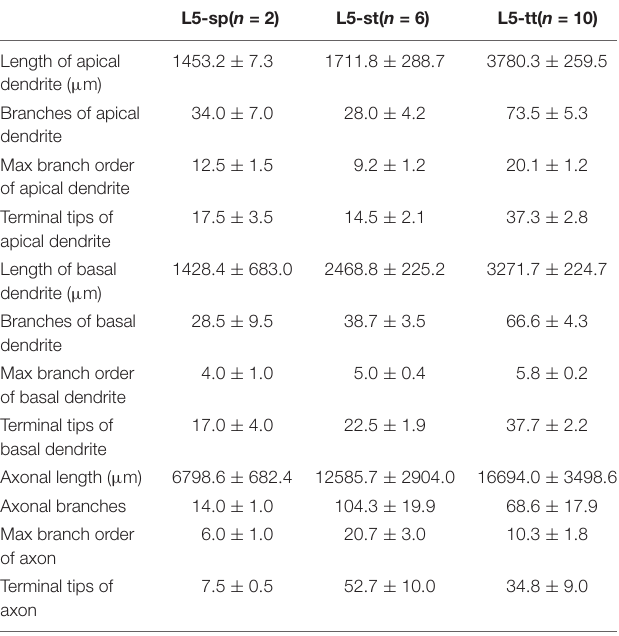
TABLE 1 | Morphological statistics of excitatory neurons in layer 5 of visual cortex.